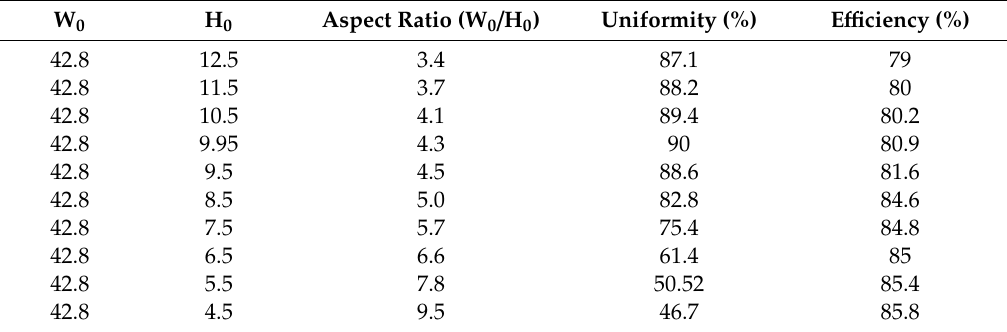
Table 2. Efficiency and uniformity of a light module at various aspect ratio values.